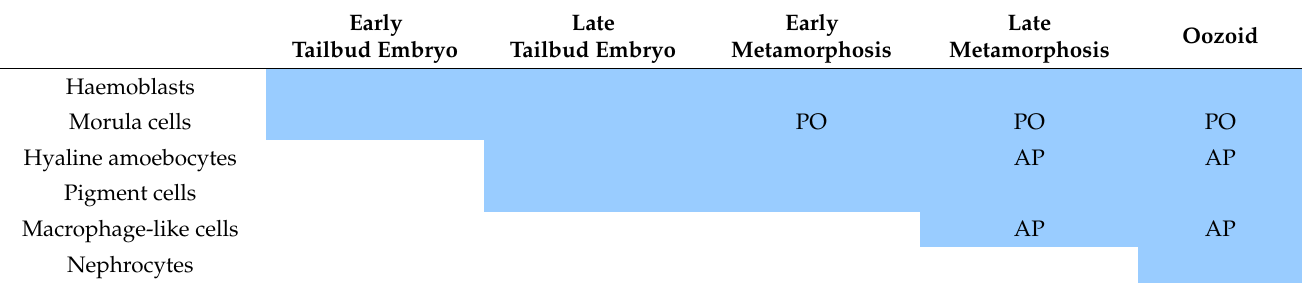
Table 1. Occurrence of the various haemocyte types and enzymatic activities of phenoloxidase (PO) and acid phosphatase (AP) during embryonic development and metamorphosis. Early Late Early Late Tailbud Embryo Tailbud Embryo Metamorphosis Metamorphosis